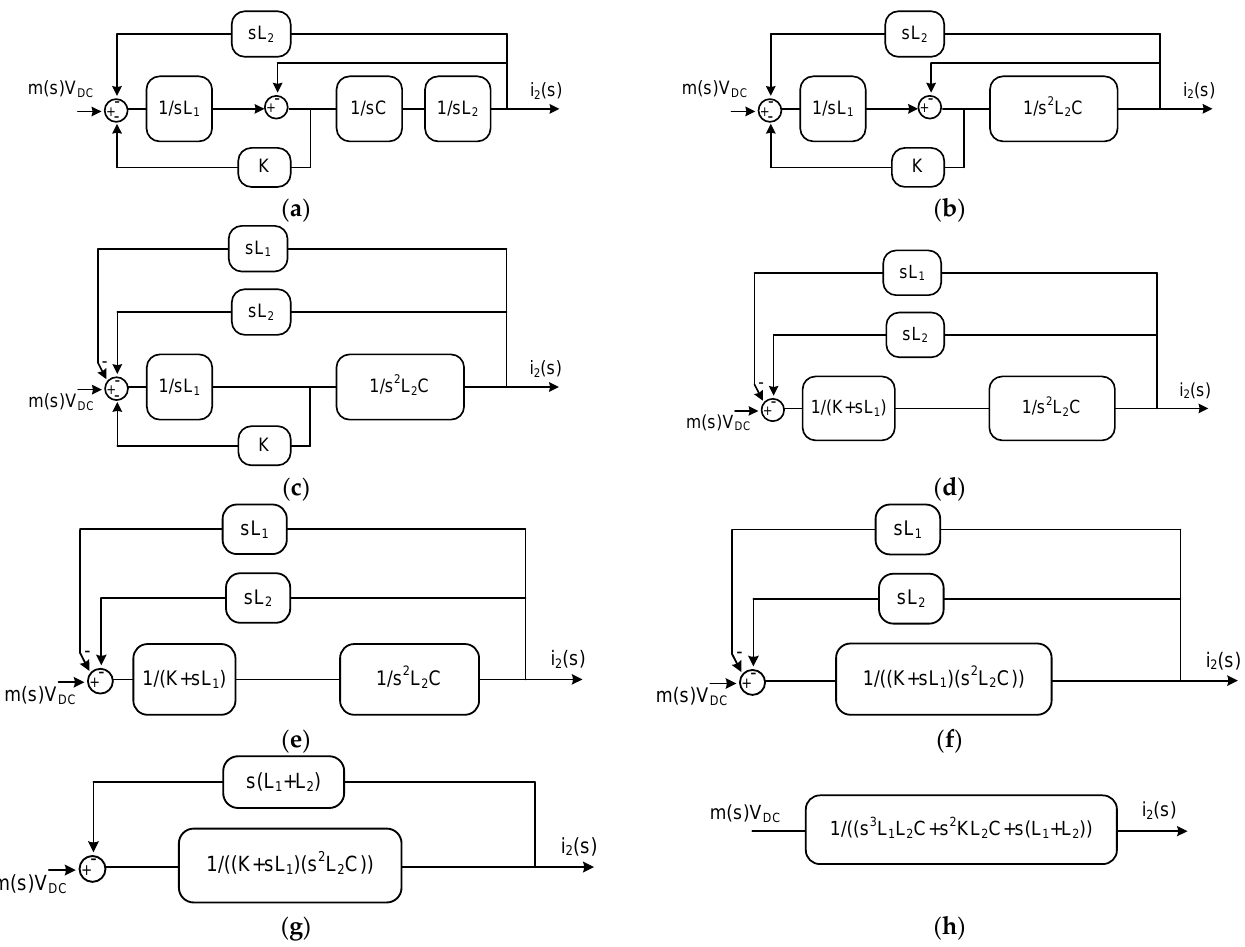
Figure A1. Obtainment of (18) through block diagram reduction ( a – h ).